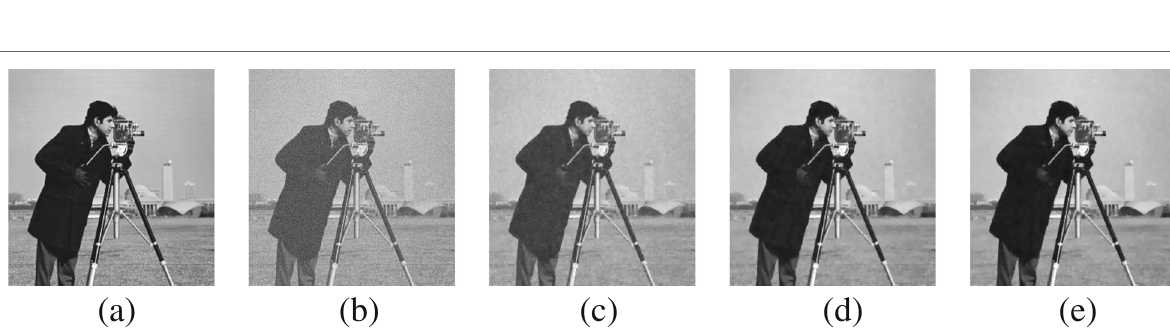
Fig. 7 Restored results on “Cameraman” image; a original image; b noisy image with σ = 22; c restored image by method M1; d restored image by method M2; e restored image by method M3